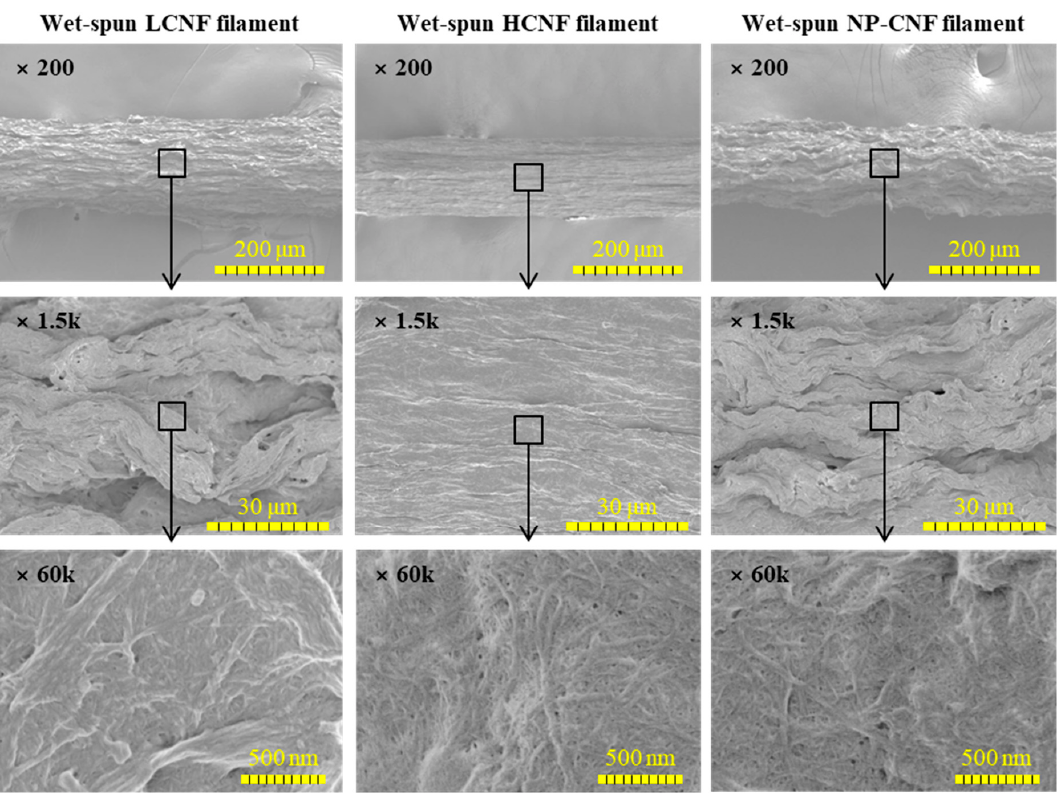
Figure 2. Morphological characteristics of the wet-spun filament prepared from 3.5 wt.% concentration of LCNF, HCNF, and NP-CNF at a spinning rate of 20 mL/min. Table 2. Average diameters and orientation indexes of the wet-spun filaments with different concentration of CNFs and spinning rates.